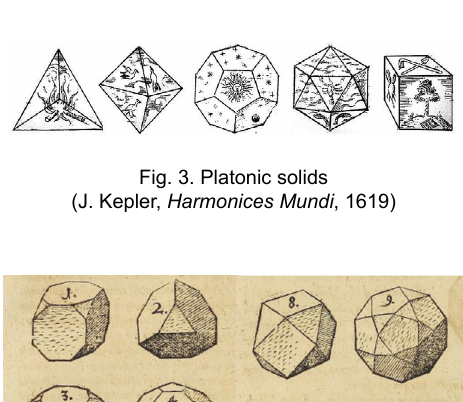
Fig. 2. Leonardo Da Vinci Ycocedron Abscisus (source: www.georgehart.com/virtual-polyhedra/ leonardo.html)